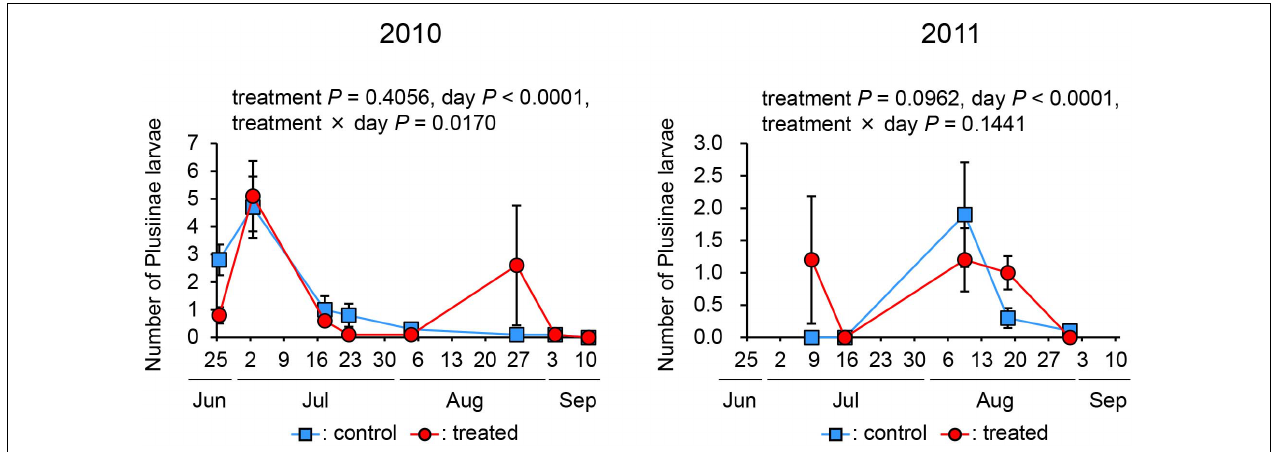
FIGURE 5 | The number of Plusiinae larvae in treated and control plots in 2010 and 2011.